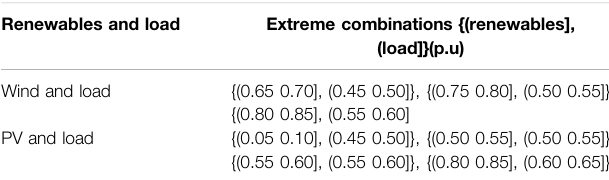
TABLE 1 | Results of extreme combinations. Renewables and load Extreme combinations {(renewables],